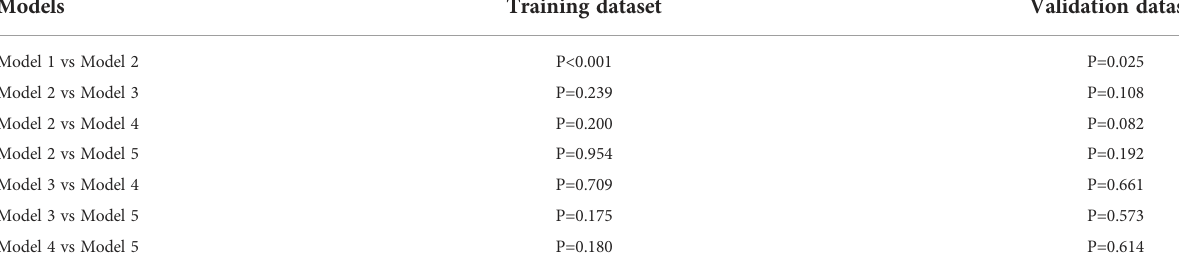
TABLE 4 Comparison among ROC curves of model 1-5 in training and validation dataset by Delong Test. Models